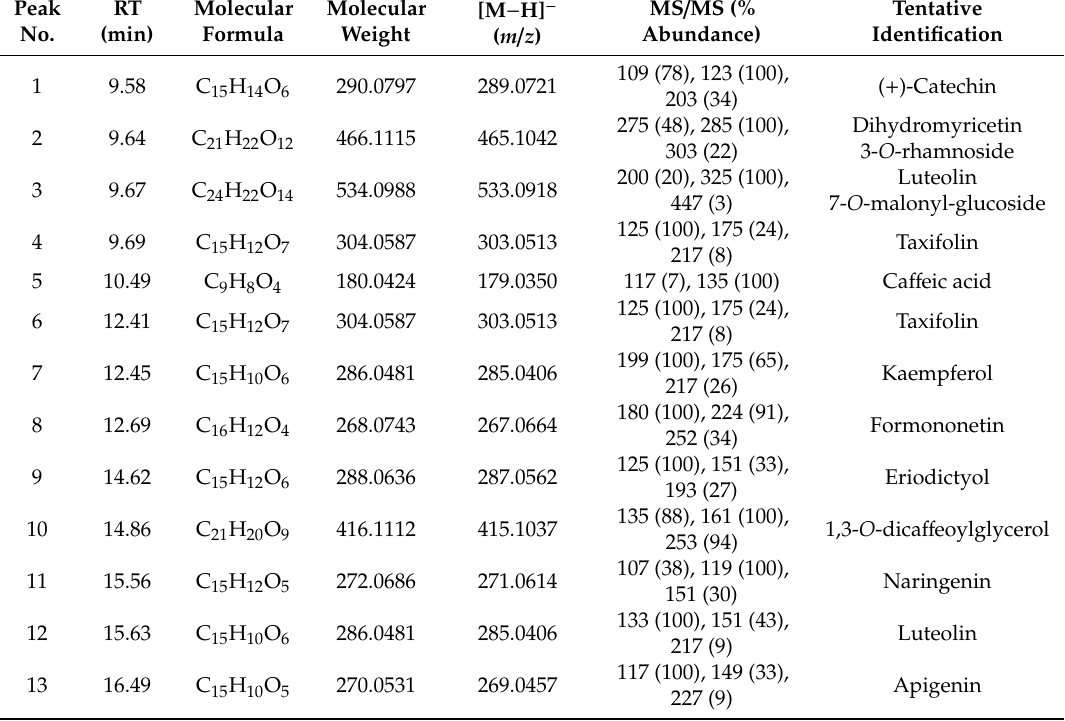
Table 3. Phenolic compounds identified in the ethanol extracts of DSOR 17 by UHPLC-Q-TOF-MS 2 . RT: Retention